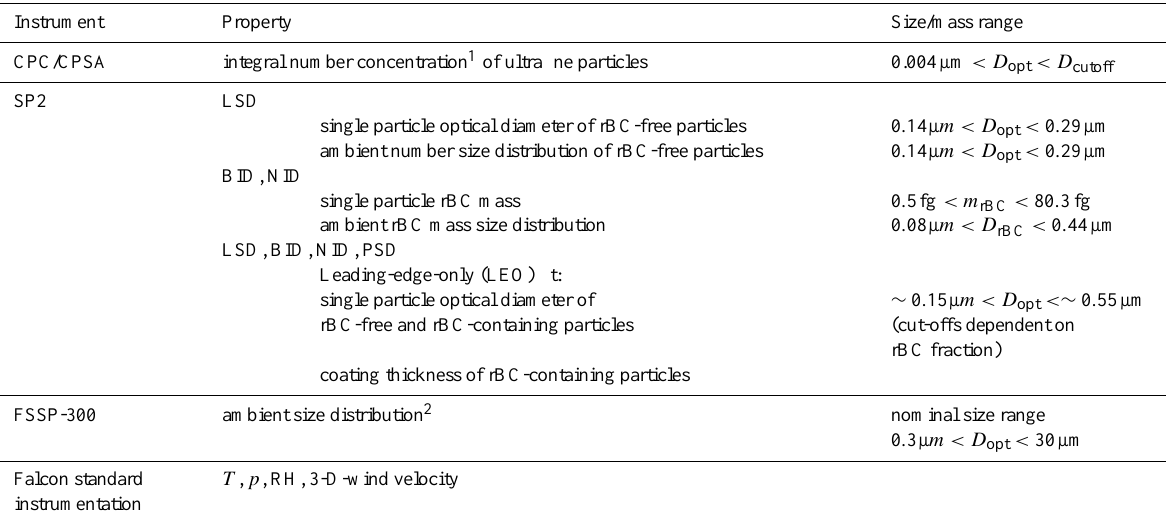
Table 1. Size ranges of the aerosol instrumentation onboard the Falcon aircraft considered in this study during the flights on 16 September 2011. The first column displays the name of the instrument, the second column the measured property, and the third column the respective size range. CPC, Condensation Particle Counter; CPSA, Condensation Particle Size Analyzer; SP2, Single Particle Soot Photometer; LSD, light scattering detector; BID, broadband incandescence detector; NID, narrowband incandescence detector; PSD, position sensitive detector; FSSP 300, Forward Scattering Spectrometer